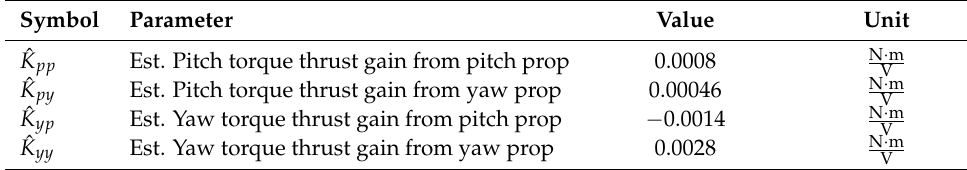
Table 2. Estimated System